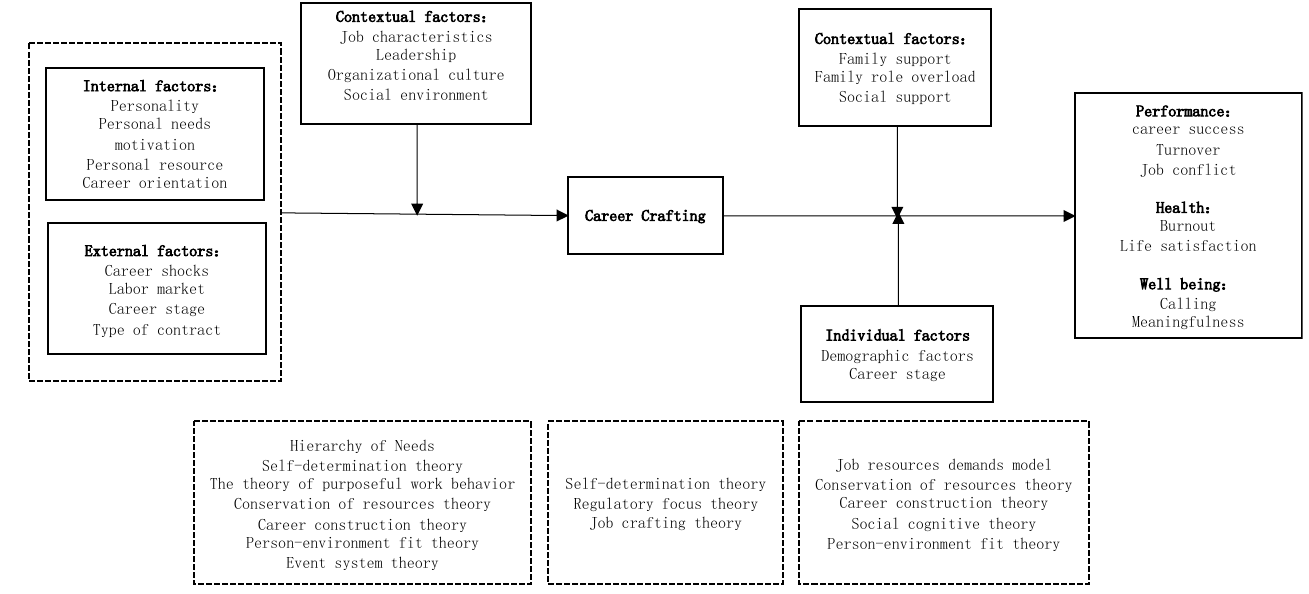
Figure 2. A model of career crafting with a testable